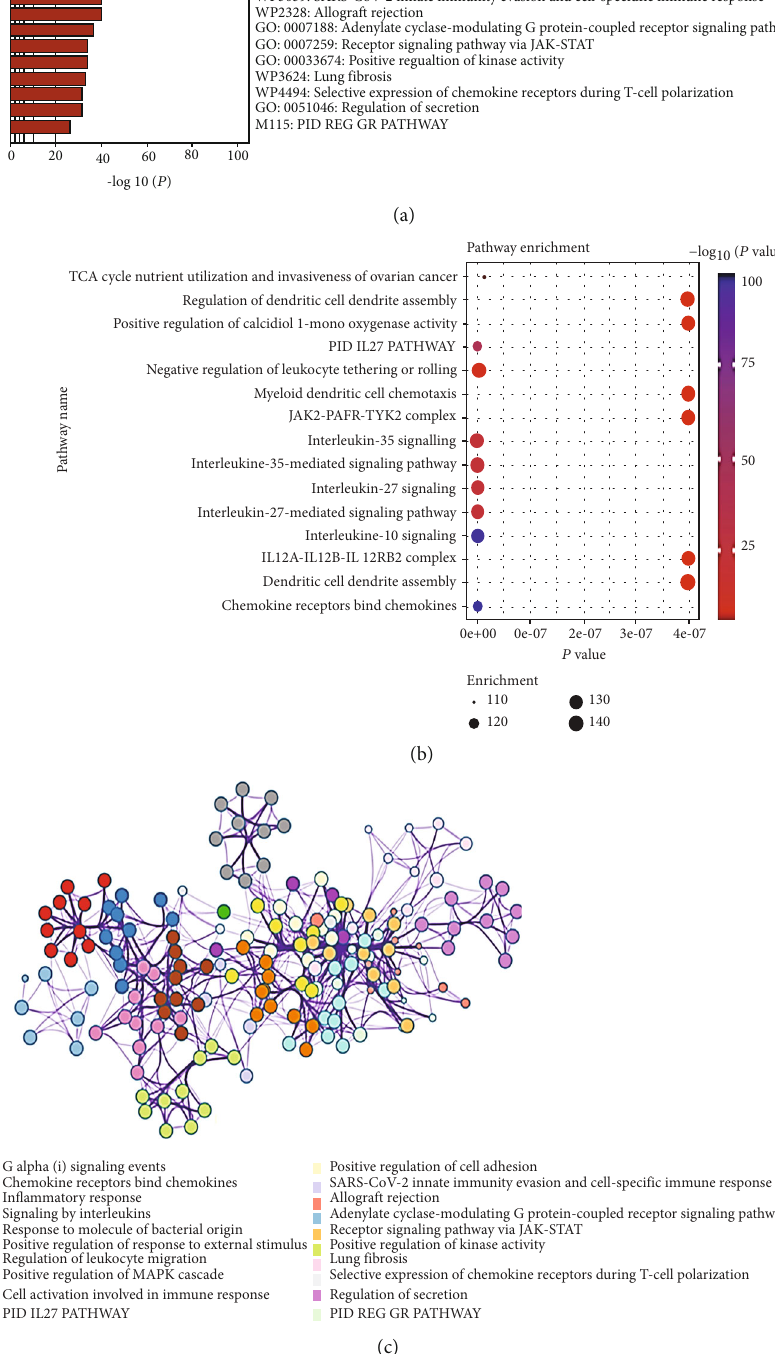
Figure 4: Interleukin-27 and CXCL9/10/11-related gene enrichment analysis. (a – c) Gene Ontology and Kyoto Encyclopedia of Genes and Genomes pathway enrichment